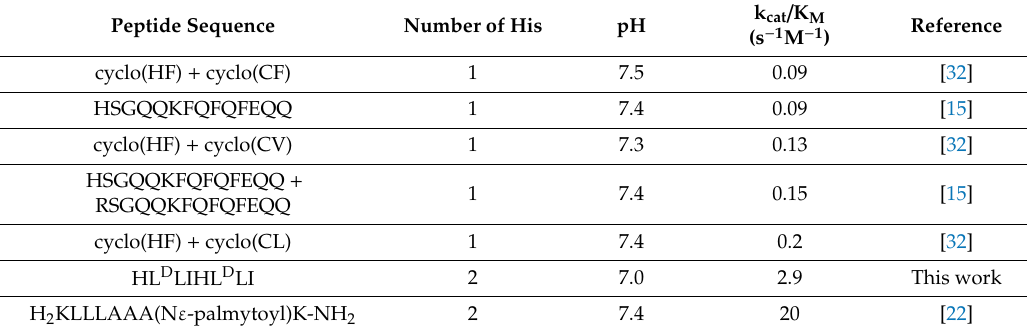
Table 2. Comparison of catalytic performance with literature data on short peptides without Zn 2 + . Peptide Sequence